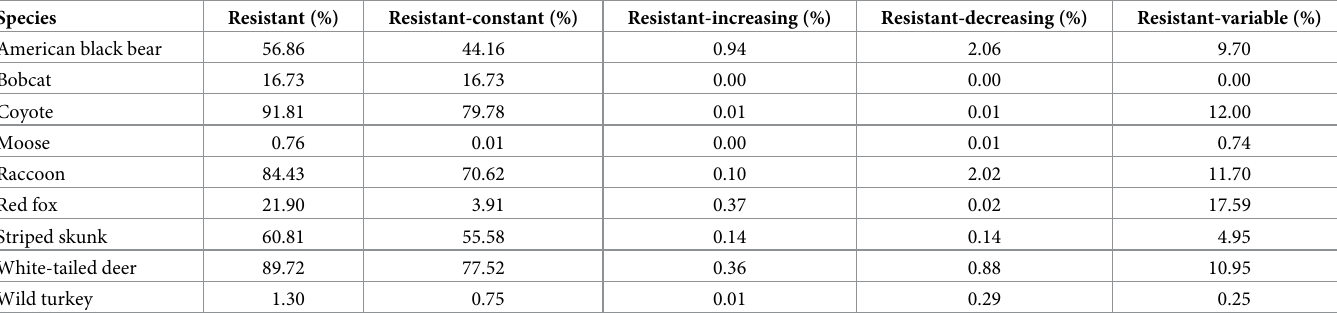
Table 3. Regional resistance statistics for nine wildlife species in New England, USA.